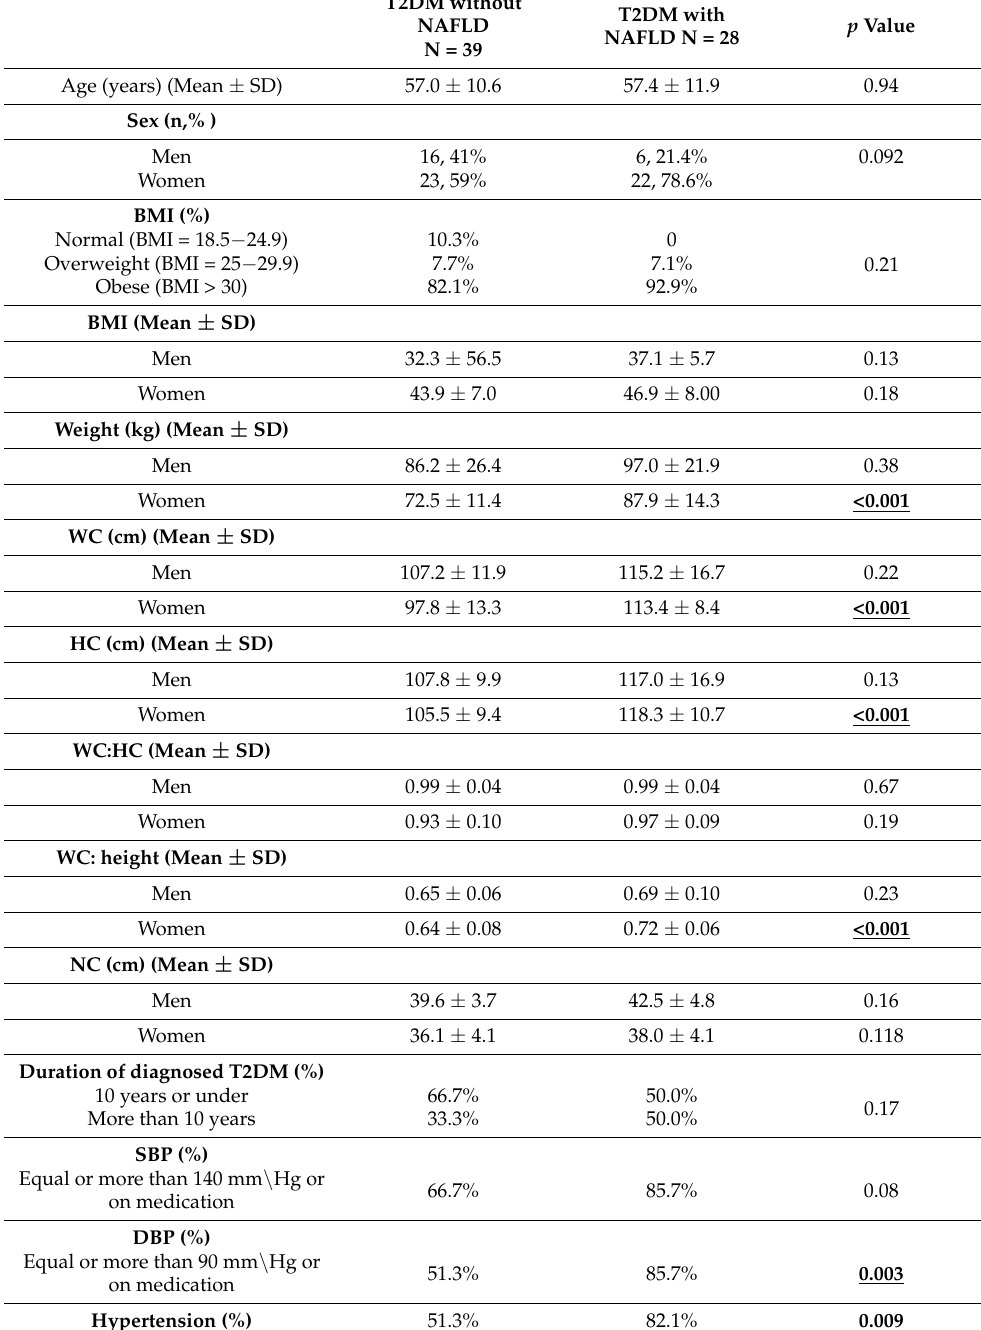
Table 1. Demographic, anthropometric, and clinical characteristics of people with T2DM with and without